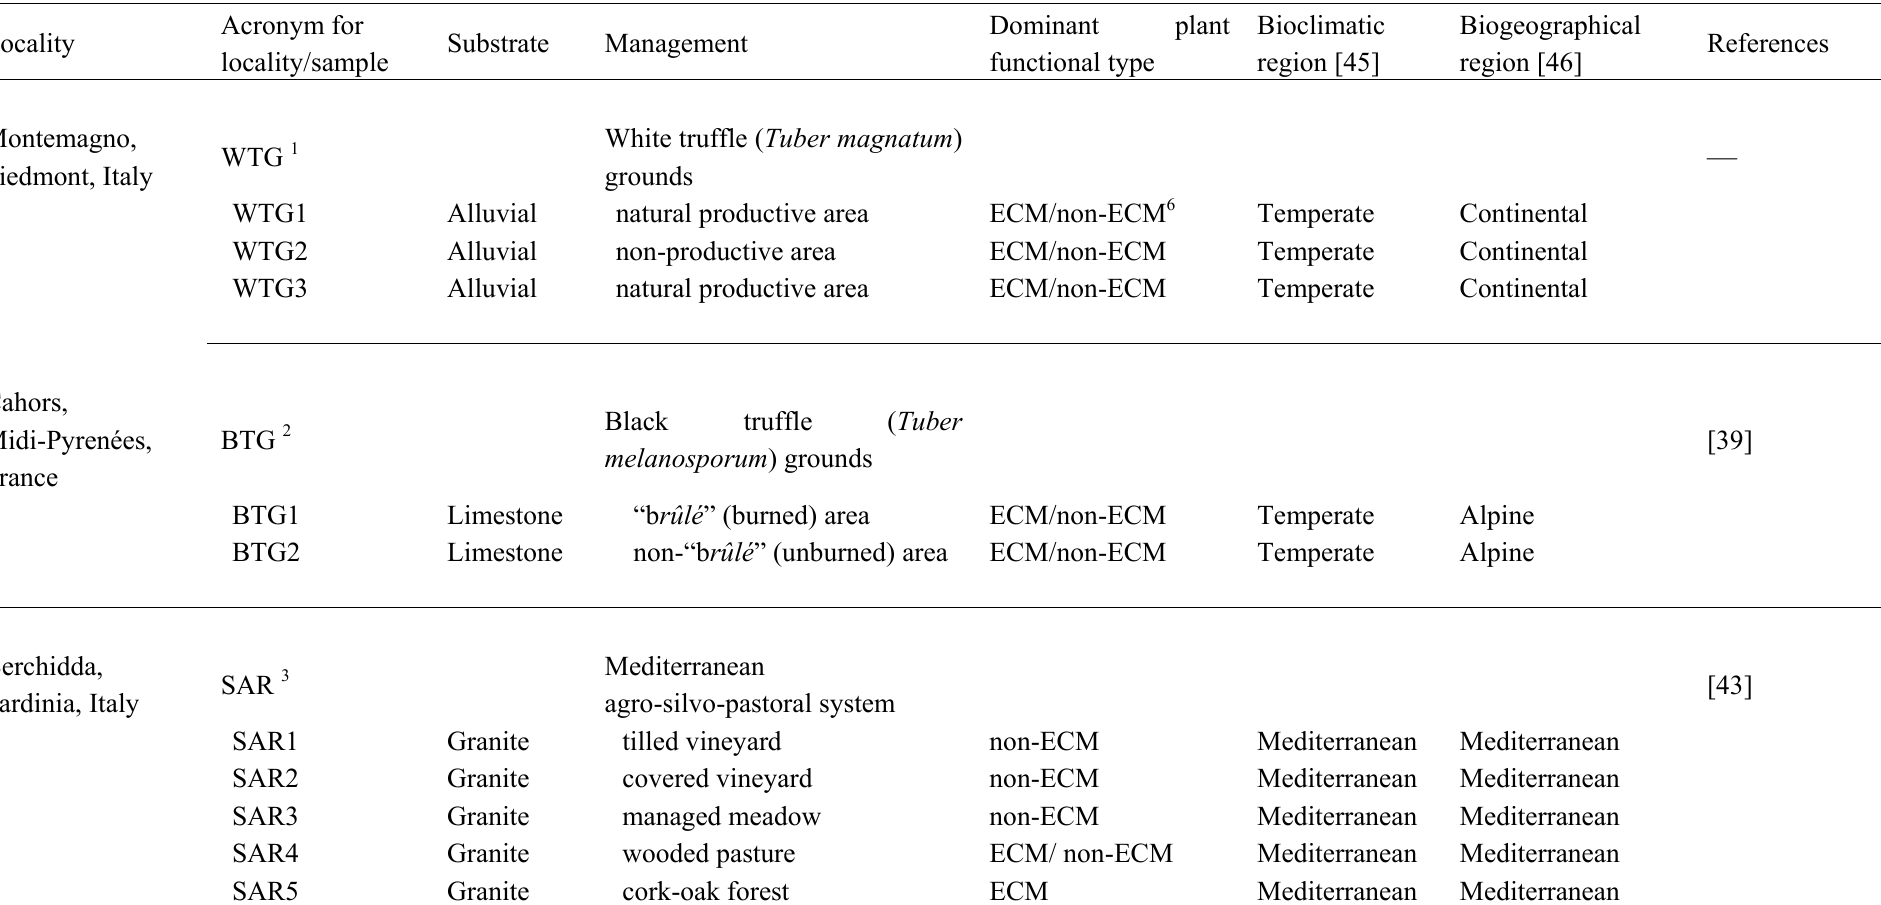
Table 1. Origin of the soil samples